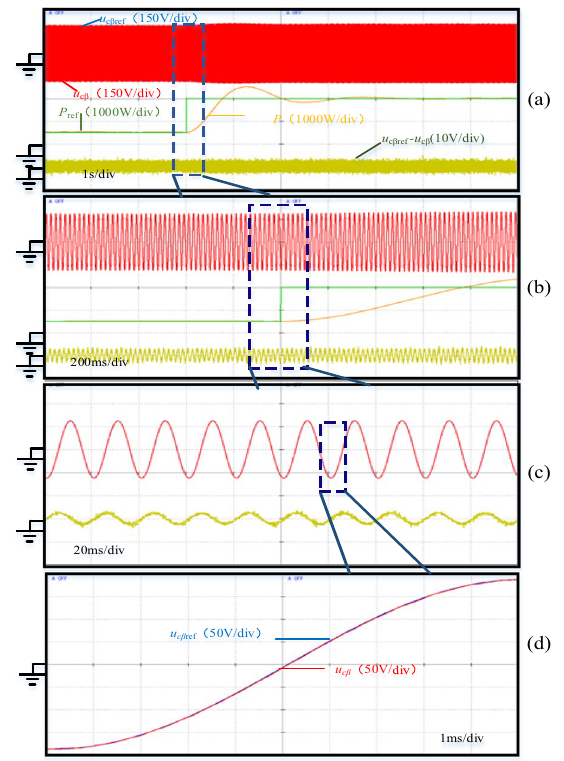
Fig. 15 Experimental waveforms during sudden change of active power with error compensation. a 1 s/div. b 200 ms/div. c 20 ms/div.